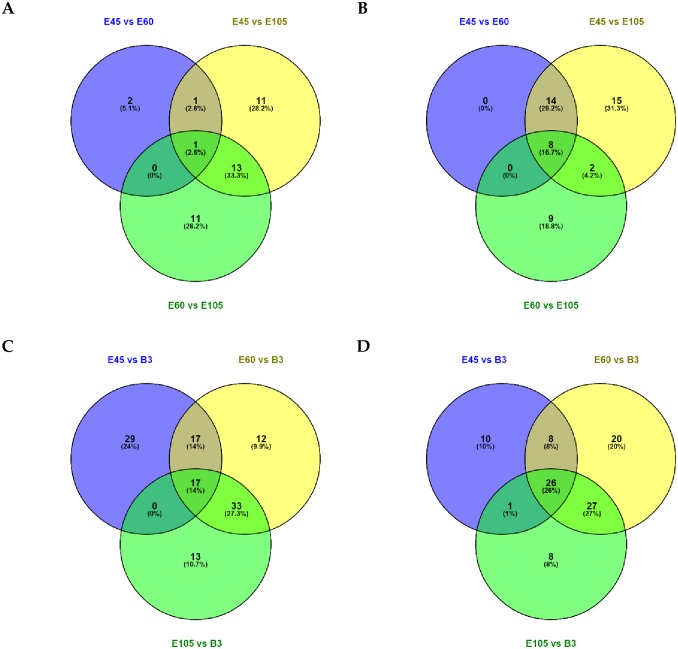
Number of commonly and uniquely DE miRNAs between the different stages of pairwise comparisons.Number of up-regulated (A) and down-regulated (B) miRNAs among prenatal stages (E45 vs E60, E45 vs E105 and E60 vs E105). Number of down-regulated (C) and up- regulated (D) miRNAs between the neonatal stage and prenatal stages (E45 vs B3, E60 vs B3, and E105 and B3). Differentially expressed miRNAs were detected using the cutoff values of |log2 (Fold change)| > 1 and FDR < 0.05. Here the fold changes were calculated from the pseudo-counts based on the UQ normalizations which was different from the fold changes based on RPM values of the miRNAs.